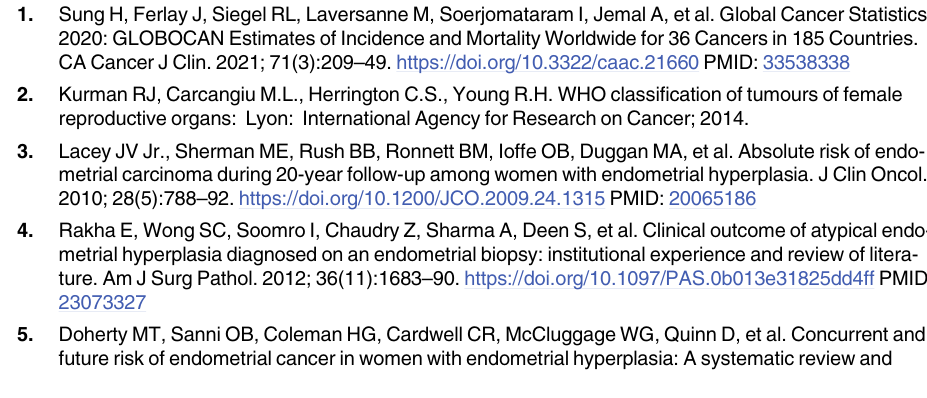
S2 Dataset. Values behind the graphs presented in Fig 2. Failure value 1 indicates a diagnosis with the endpoint (atypia or carcinoma). Failure value 0 indicates that the endpoint was not met, i.e., no diagnosis with atypia or carcinoma. (XLSX) S3 Dataset. Values behind the median follow-up time and median time to progression to atypia or carcinoma presented in Table 4. Index test = initial histological sample with non- atypical hyperplasia between 2000–2015. NA = Not